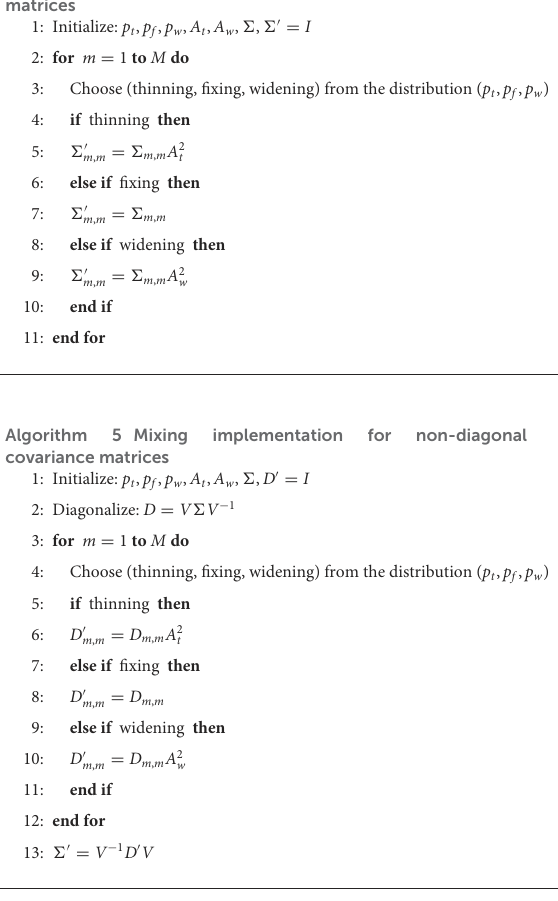
Algorithm 4 Mixing implementation for diagonal covariance matrices